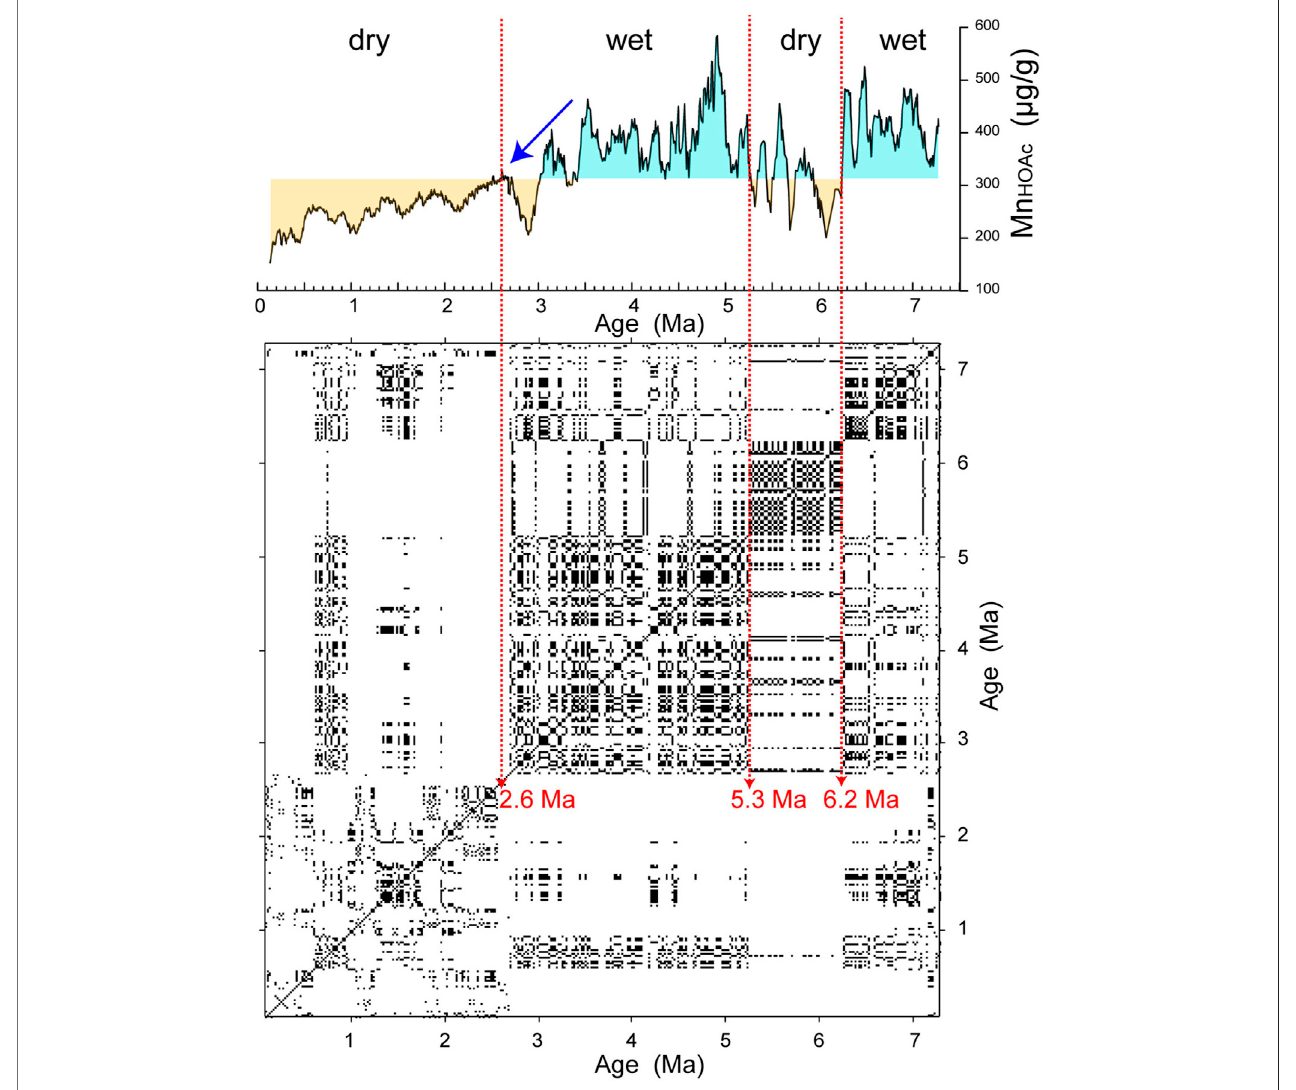
FIGURE 7 | Plots of Mn HOAc 100-kyr sliding window means (top) and recurrence analysis of Mn HOAc variation (bottom) for the integrated SG-1 and SG-1b data, showing major climate transitions during the past 7.3 Myr. Red arrows show the three major transitions at around 6.2 Ma, 5.3 Ma and 2.6 Ma, which correspond to the major boundaries between dry and wet stages as suggested by the Mn HOAc data in the upper panel. The blue arrow marks the beginning of the Pliocene drying since ∼ 3.6 Ma.